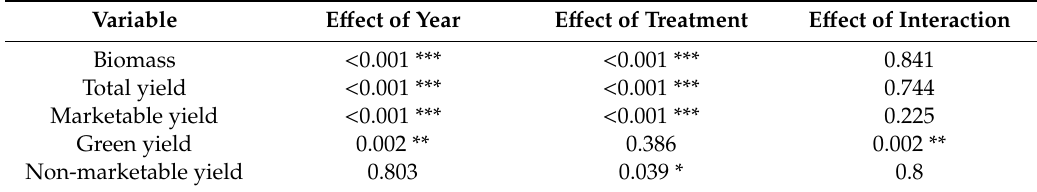
Table 3. Two-way ANOVAs regarding tomato production variables.